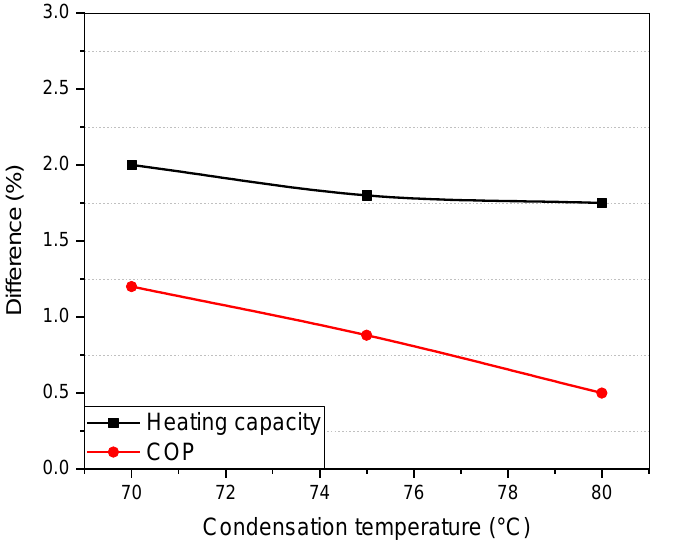
Figure 4. Validation of the current model compared with commercial software for the heat capacity and COP estimation at the evaporation temperature of 32 °C.